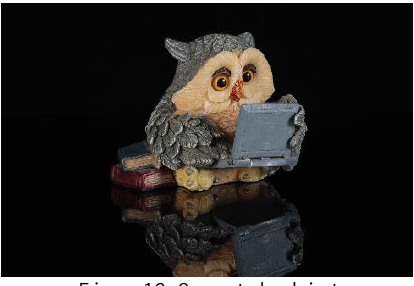
Figure 12: Case study object